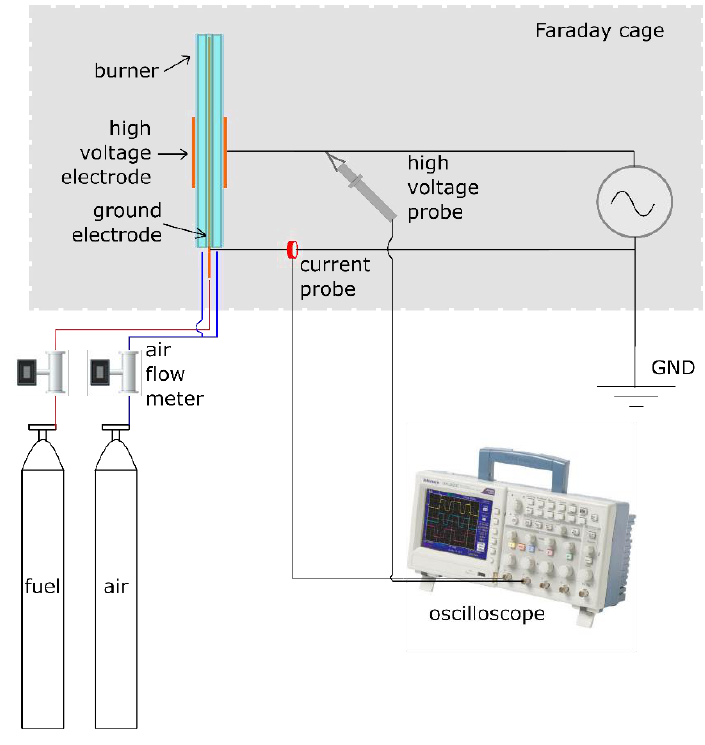
Figure 1. Diagram of the experimental electrical setup.